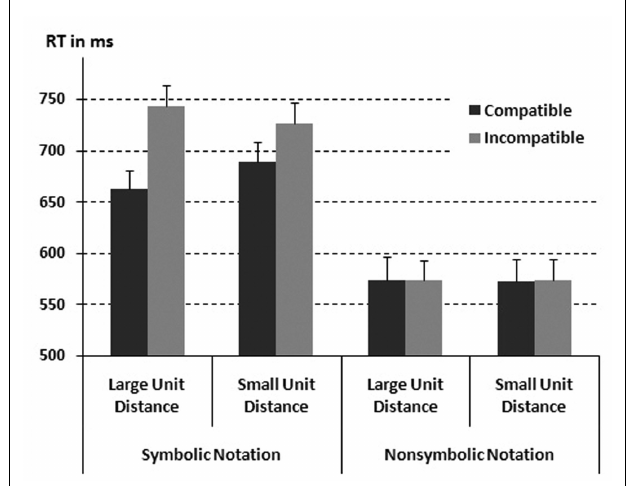
FIGURE 2 | Response latencies for compatible and incompatible comparisons separated for symbolic and unstructured non-symbolic notation and large vs. small unit distance. Error bars indicate 1 standard error of the mean (SEM).